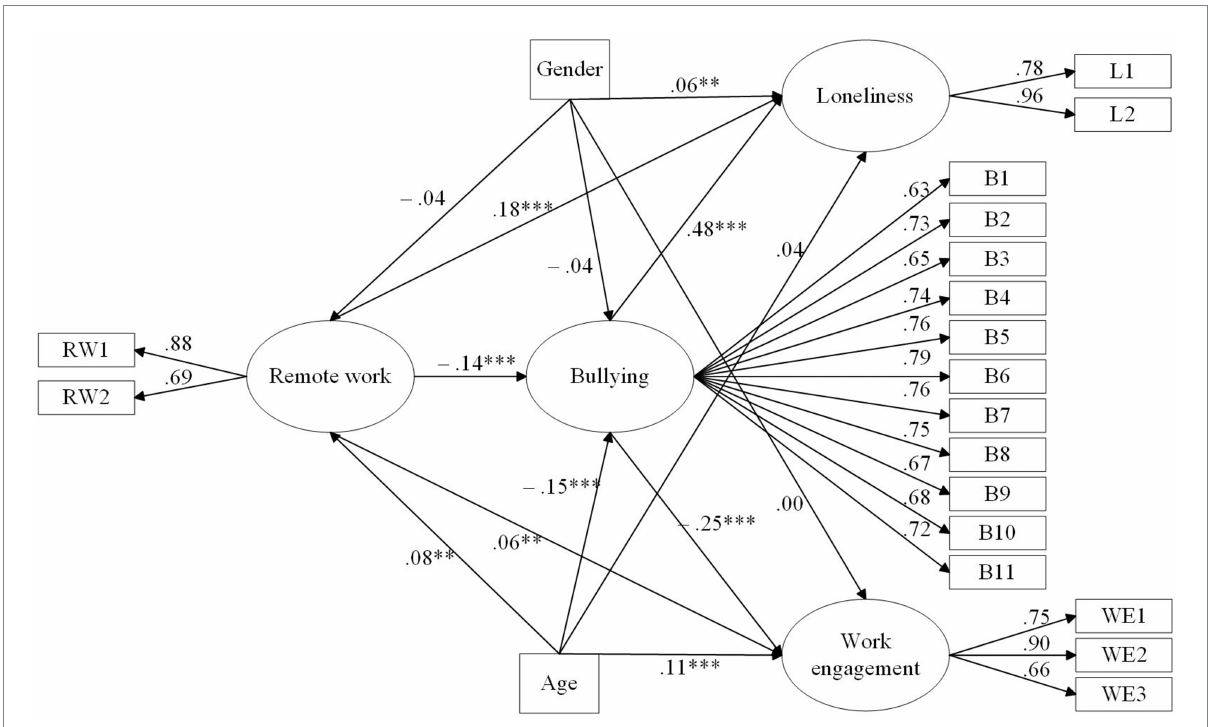
FIGURE 2 Result of structural equation modeling conducted on Norwegian workers with standardized path coefficients. Gender (0 = Male, 1 = Female); ** p < 0.05, *** p < 0.01.